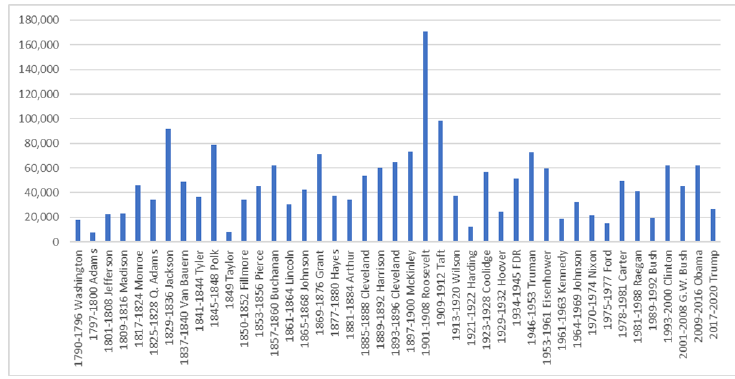
Figure 1. Size (number of words) of each president’s